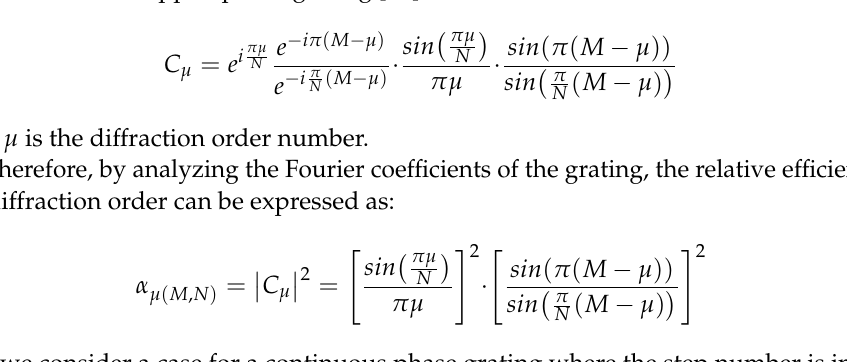
Figure 6. Phase profile of a blazed phase stepped grating on an LCOS SLM with period d, maximum phase depth M2 π , and N steps.